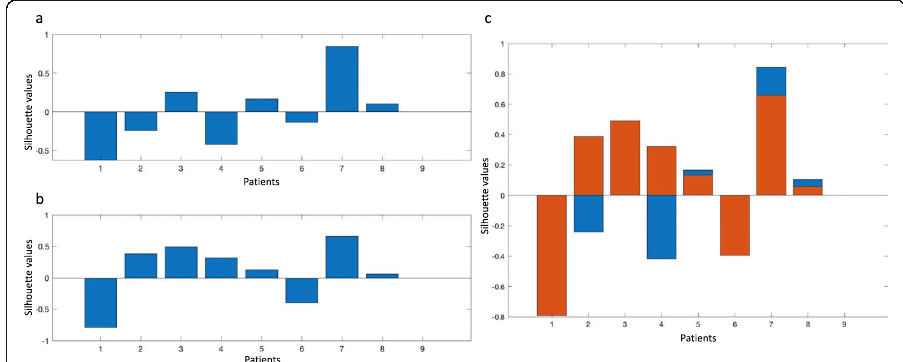
Fig. 4 Silhouette results among non-relapsing/refractory patients. Patient-wise silhouette among non- relapsing/refractory patients with lymph nodal ( a ) and all ( b ) lesions. Variations of patient-wise silhouette with/without extra-nodal lesions ( c